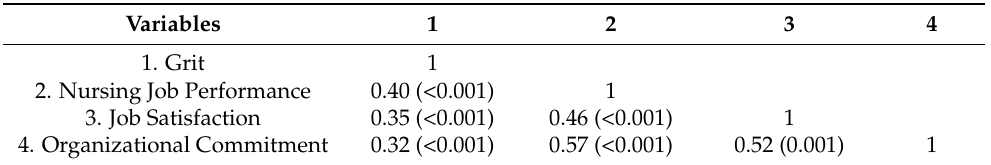
Table 2. Correlation between grit, nursing job performance, job satisfaction, and organizational commitment of participants.